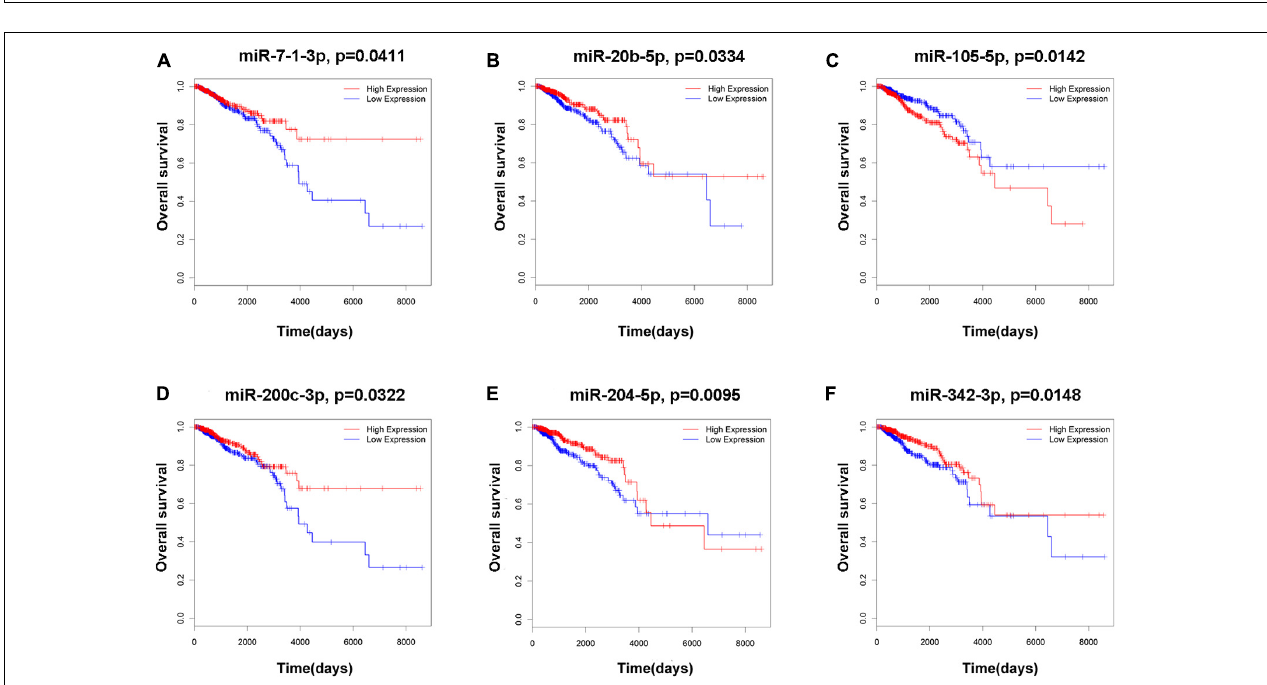
FIGURE 4 | Biological function analysis of aberrantly expressed genes regulated by the miR-93/20b/106a/106b family in breast cancer. (A) Gene ontology terms analysis. (B) Pathways enrichment analysis. Squares represent miRNAs, balls represent mRNAs, and balls with a circle around represent lncRNAs. Red means upregulated genes, while green means downregulated genes. Arrows represent the GO terms, and triangles represent the pathway terms.